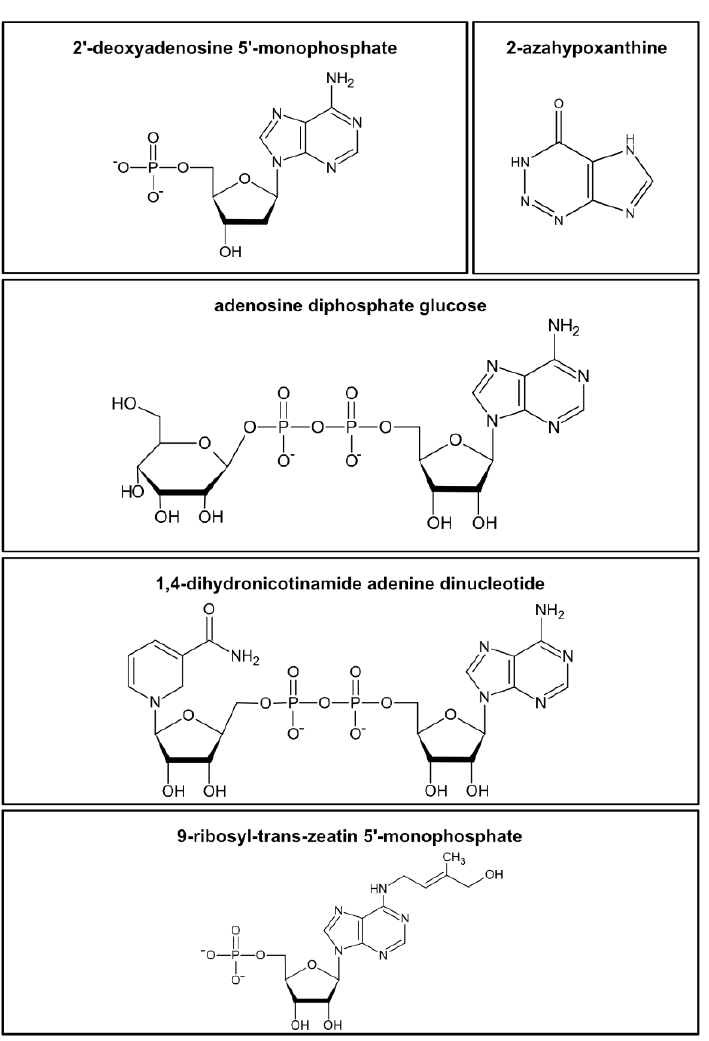
Figure 1. Examples of the diversity of nucleotides and structurally related metabolites in plants. Examples are shown for a nucleotide monophosphate (2 ′ -deoxyadenosine 5 ′ -monophosphate), a “fairy chemical” (2-azahypoxanthine), a nucleotide sugar (adenosine diphosphate glucose), a nucleotide cofactor (1,4-dihydronicotinamide adenine dinucleotide, NAD), and a cytokinine-ribotide (9-ribosyl-trans-zeatin 5 ′ -monophosphate).